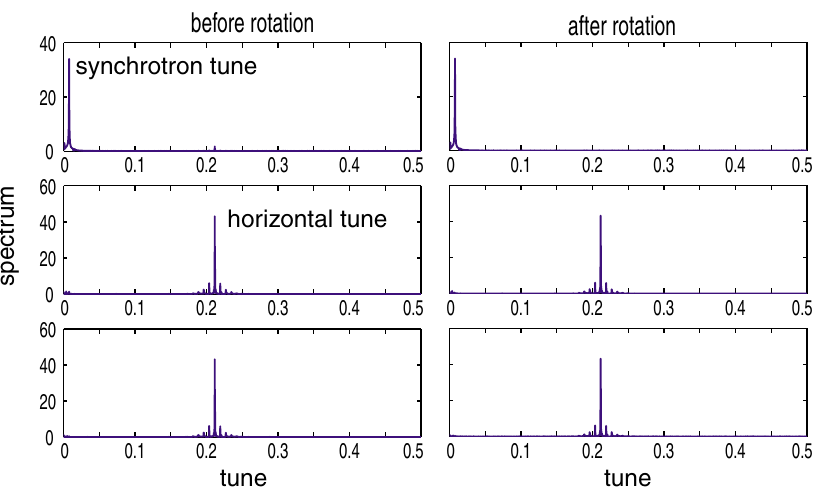
FIG. 5. (Color) The spectra of the first three modes using 186 BPMs. The spectra of the SVD modes are on the left and there is a little mode mixing. The spectra of the rotated SVD modes are on the